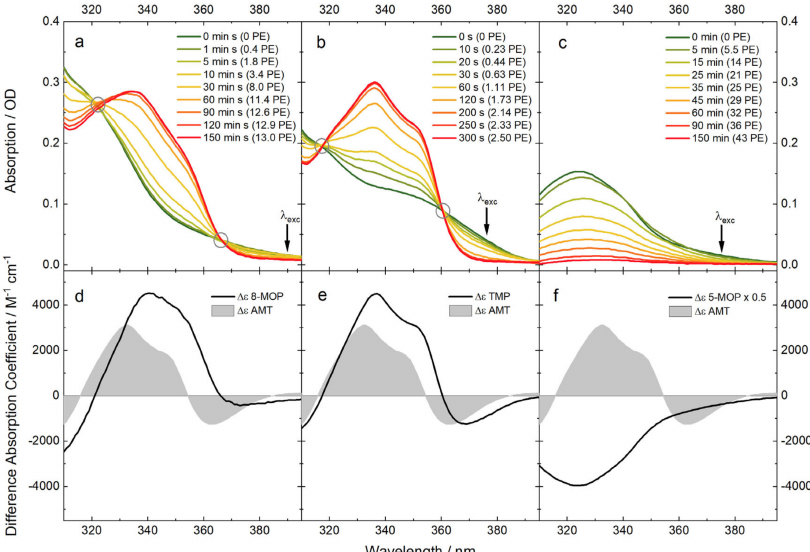
Figure 2. Photoaddition of psoralens to AT-DNA traced by UV / Vis absorption. Irradiation intervals are given in seconds and in photon equivalents (PE). Circles mark isosbestic points. Absorption contributions of the DNA were subtracted: ( a ) Spectra of 8-MOP (33 µ M) and AT-DNA (4 mM) in PBS bu ff er after indicated irradiation times ( λ exc = 390 nm, P = 9.5 mW, V = 2.2 mL, d = 1 cm); ( b ) Spectra of TMP (38 µ M) and AT-DNA (3.3 mM) in PBS bu ff er after indicated irradiation times ( λ exc = 375 nm, P = 7.5 mW, V = 2.4 mL, d = 1 cm); ( c ) Spectra of 5-MOP (18.4 µ M) and AT-DNA (2 mM) in PBS bu ff er after indicated irradiation times ( λ exc = 375 nm, P = 15 mW, V = 2 mL, d = 1 cm); ( d – f ) Di ff erence absorption spectra obtained from the data above are compared to the one of AMT with AT-DNA